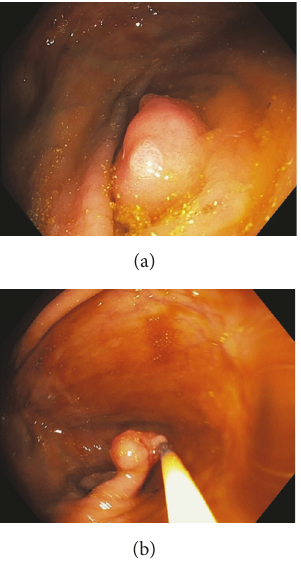
Figure 42: Endoscopic images of an appendiceal submucosal neuroma with a diminutive tubular adenoma on the top (a). The neuromais found to be pedunculated and arises from Appendix (b). The lesion was completed removed by snare polypectomy.